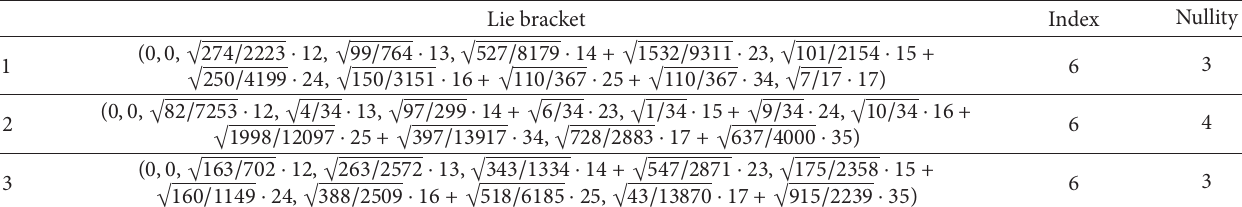
Table 2: 8-dimensional nilsoliton metric Lie algebras.